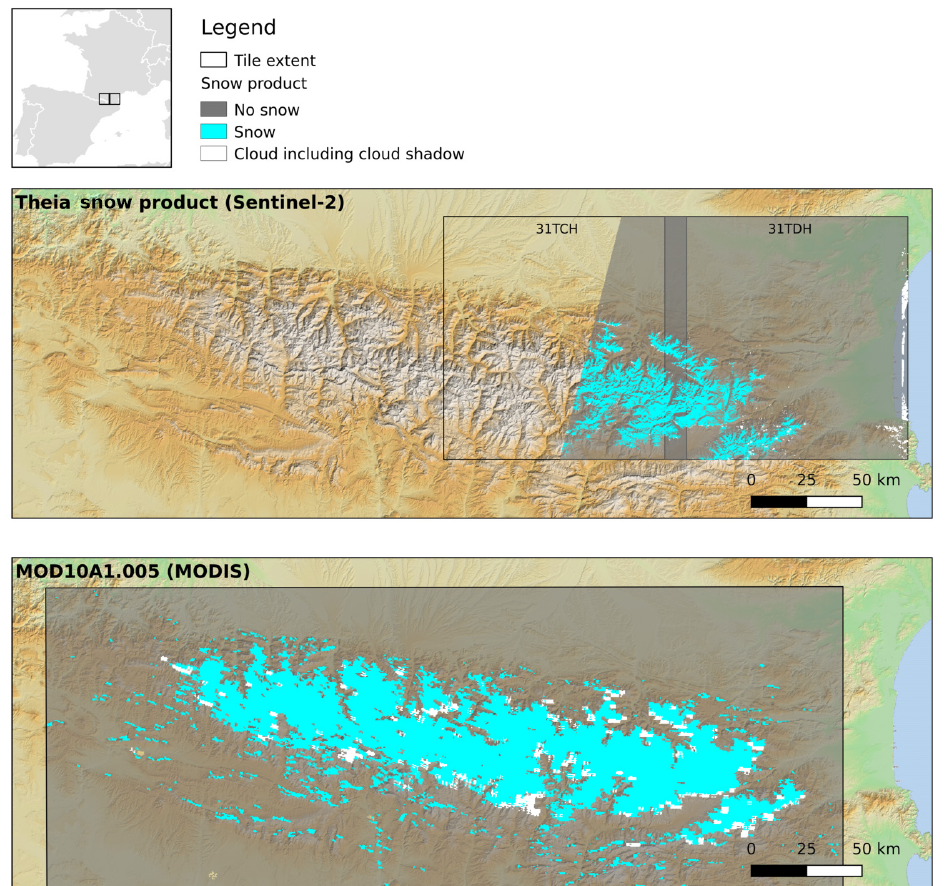
Figure 5. Map of the first two products in the Theia Snow collection and comparison with MOD10A1.005 snow product of the same day. The map background is the colourized version of the EU DEM.